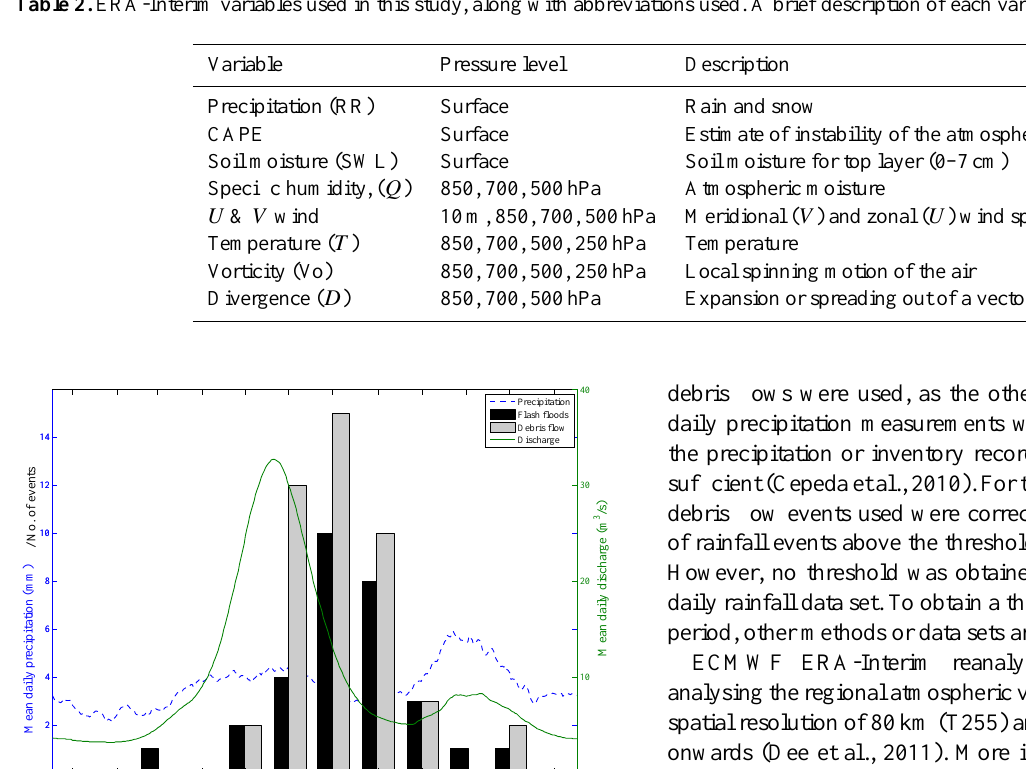
Table 2. ERA-Interim variables used in this study, along with abbreviations used. A brief description of each variable is also given.